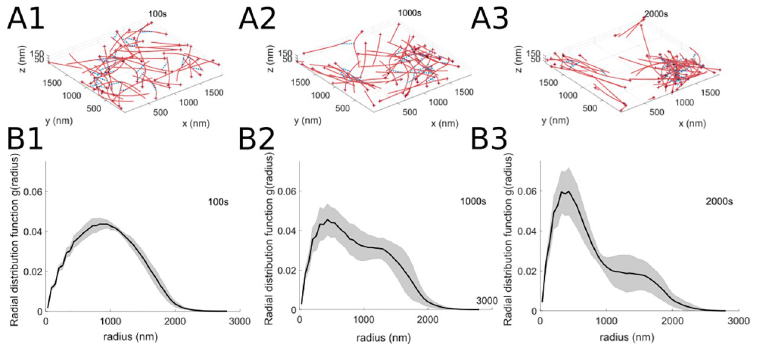
Fig 2. Simulation results using standard parameters (Table 1). Baseline simulation snapshots at times (A1) t = 100, (A2) t = 1000, and (A3) t = 2000s, with actin filaments depicted as long red polymers, plus ends of filaments indicated in dark red, myosin motors represented as medium-length dashed blue lines, and cross-linkers shown as short black lines. The parameter values used are d step = 6 nm, k head.bind = 0.2/s, F s = 100 pN, range heads = 15–30 (see Table 1). (B1-B3) Radial distribution function, indicating the density of pairwise distances between actin filaments (§ 5.3), for the corresponding single time point snapshots in (A). The radial distribution function indicates filaments become more clustered over time, consistent with the simulation snapshots. In all panels, solid lines indicate the average, and shaded areas indicate the standard deviation over 10 independent stochastic runs. See Fig 3 for further measures of actin filament and motor protein organization in these